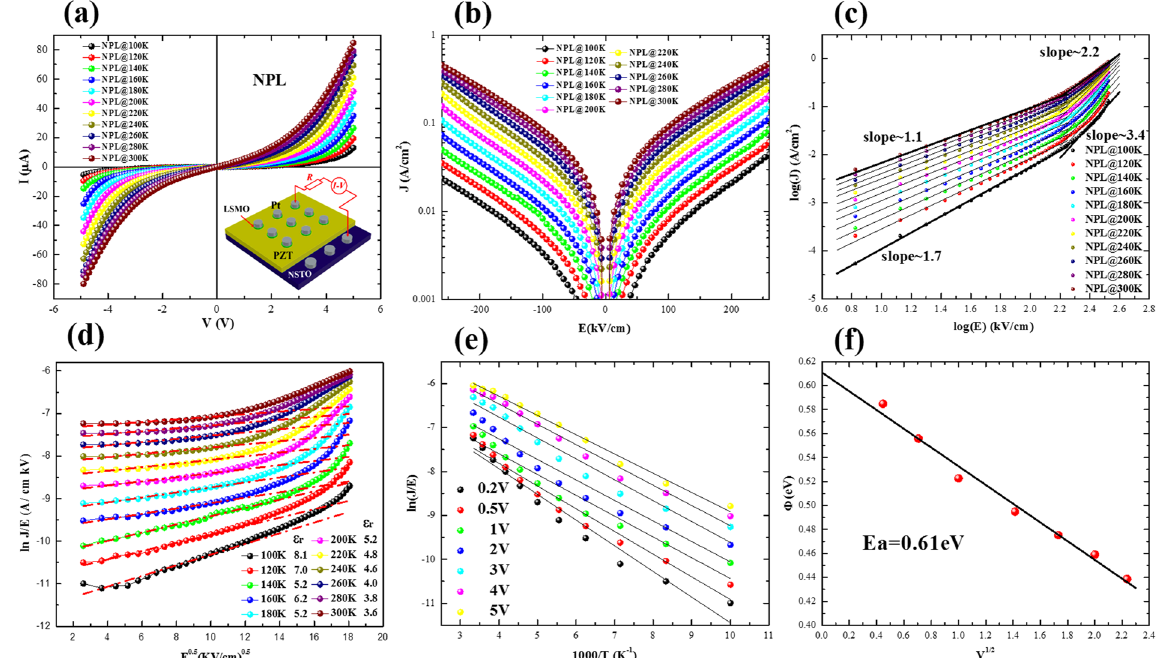
Figure 5. ( a ) Illustration of I-V measurements under different temperatures, ( b ) temperature and voltage dependence of J, ( c ) SCLC analysis at positive region, ( d ) ln(J/E) ~ E 1/2 at negative region, ( e ) temperature dependence of ln(J/E), and ( f ) relationships between activation energies and voltage for the NPL